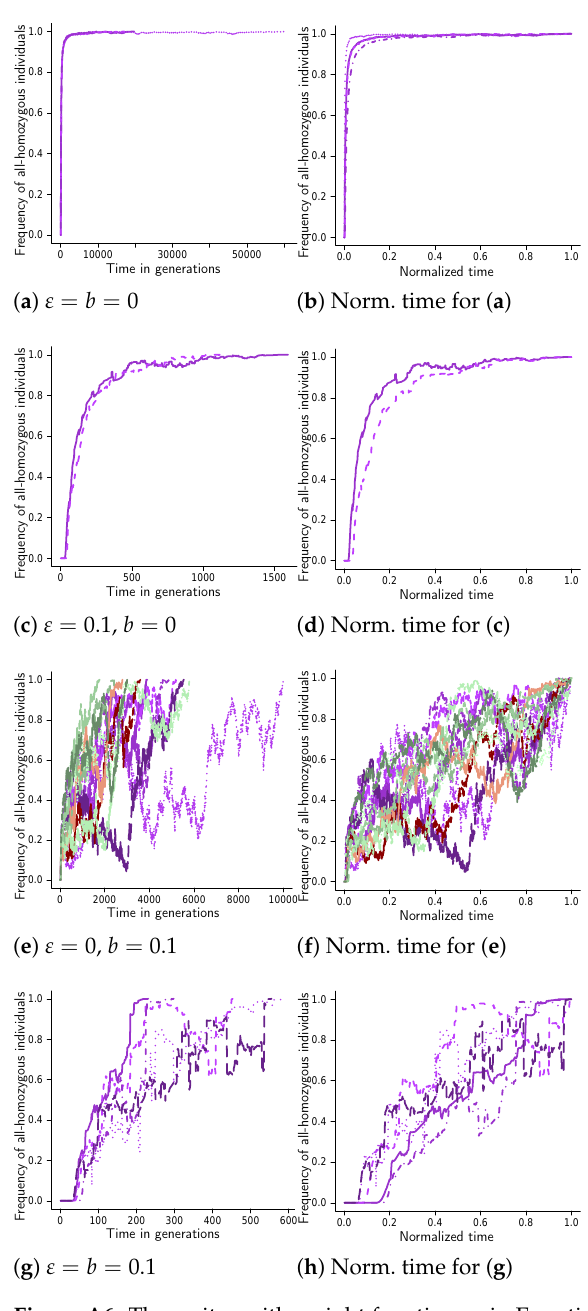
Figure A6. Three sites with weight function as in Equation (A3). Examples of fixation trajectories for fixation at three sites with weight function given by Equation (A3), carrying capacity C = 10 6 , cutoff u ( N ) = C , probability of recombination r = 0.25 between adjacent sites, α 1 = 0.75, α 2 = 3, ε (see Equation (7)) and probability of a bottleneck b as shown, strength of selection s = 0.1 and bottleneck B = 10 3 ; ( a , c ) from ten experiments, ( e , g ) from 10 2 experiments. Each trajectory traces, as a function of time, the number of diploid individuals homozygous for the fit type at all sites relative to the population size (the number of diploid individuals). The panels on the right ( b , d , f , h ) show the corresponding excursions from the left panels ( a , c , e , g ), where the time to fixation for each excursion is normalized by the time to fixation for the excursion. The scale of the abscissa (time axis) may vary between panels; in each panel, the trajectories were all obtained under identical